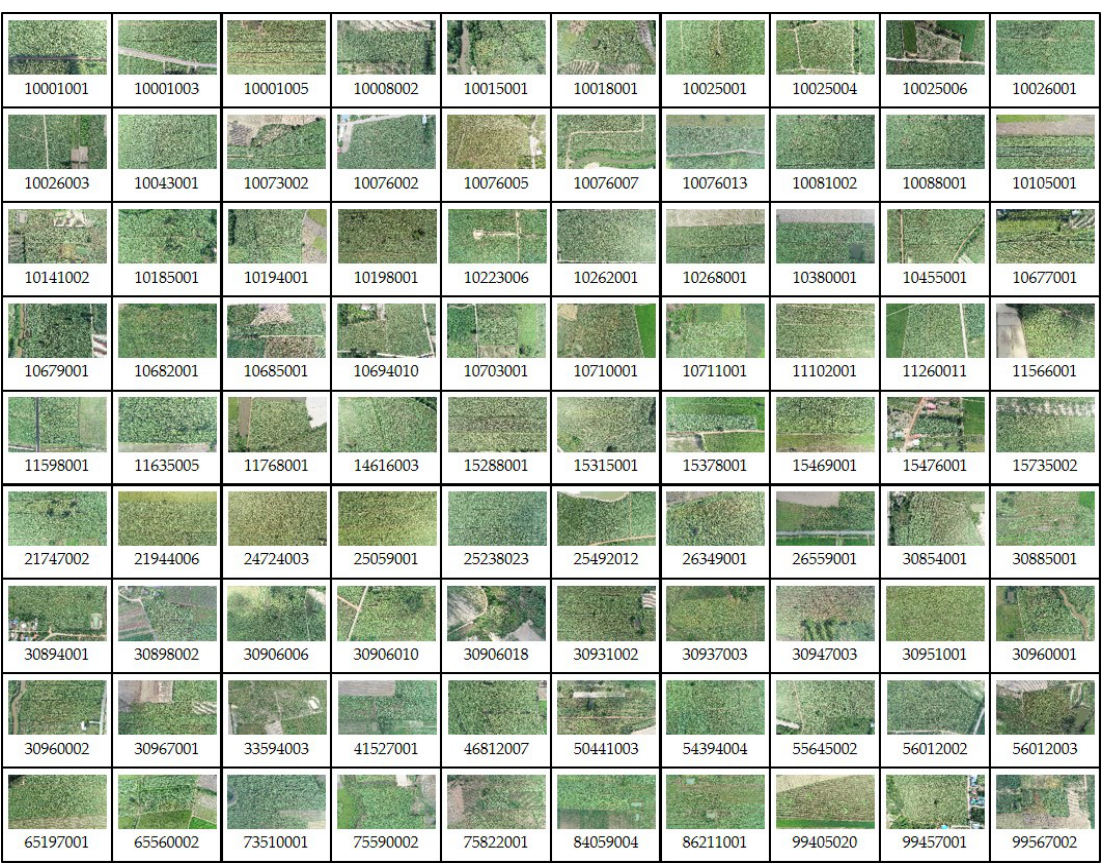
Figure 3. The data collection of the sugarcane plantation